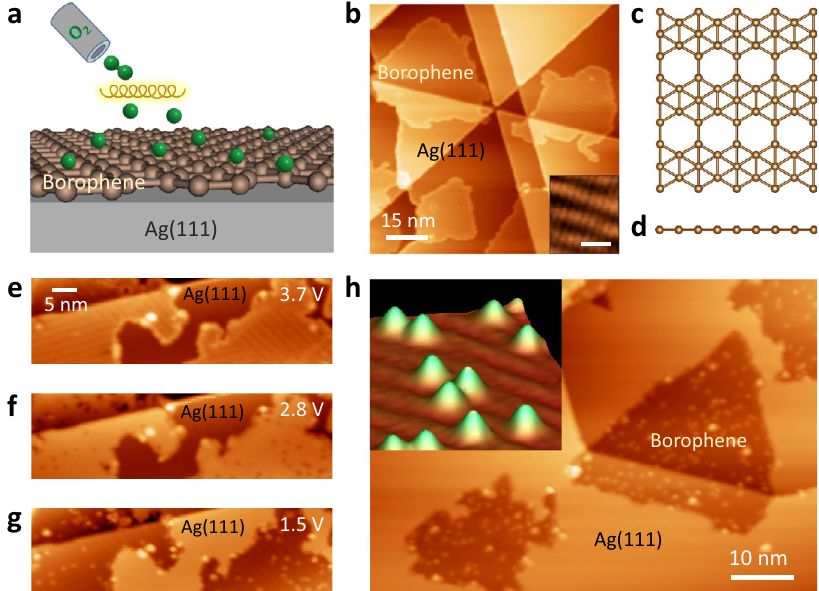
Fig. 1 Oxidation of v 1/6 borophene with atomic oxygen. a Schematic illustration of the experimental setup, with a heated iridium fi lament (yellow) used to produce atomic oxygen (green spheres) by cracking O 2 molecules. b STM image of as-prepared v 1/6 borophene sheets on Ag(111). Inset: atomic-resolution imaging of the v 1/6 borophene structure; scale bar: 2 nm. c Top and d side views of the atomic structure of v 1/6 borophene. e – g STM images of borophene sheets following exposure to 6 L of atomic oxygen, all of the same region with different scanning biases as indicated. Borophene islands are imaged as depressions in g . Uniformly shaped depressions ( f ) and protrusions ( g ) randomly distributed on borophene correspond to oxygen adatoms. h Large-scale oxidized v 1/6 borophene sheets. Inset: three-dimensional rendered STM image of oxygen adatoms on borophene. Scanning parameters: b 3.8 V, 200 pA; e 3.7 V, 100 pA; f 2.8 V, 100 pA; g 1.5 V, 100 pA; h 1.3 V, 200 pA.